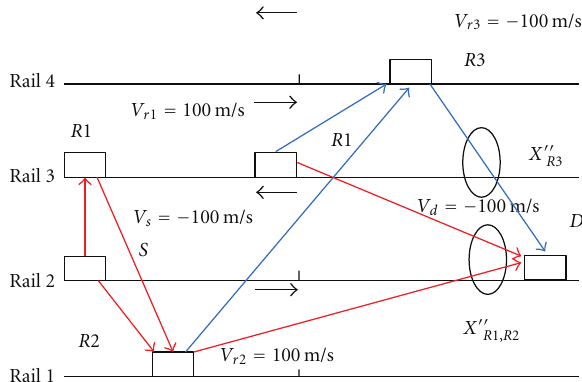
Figure 4: Communication model of Case